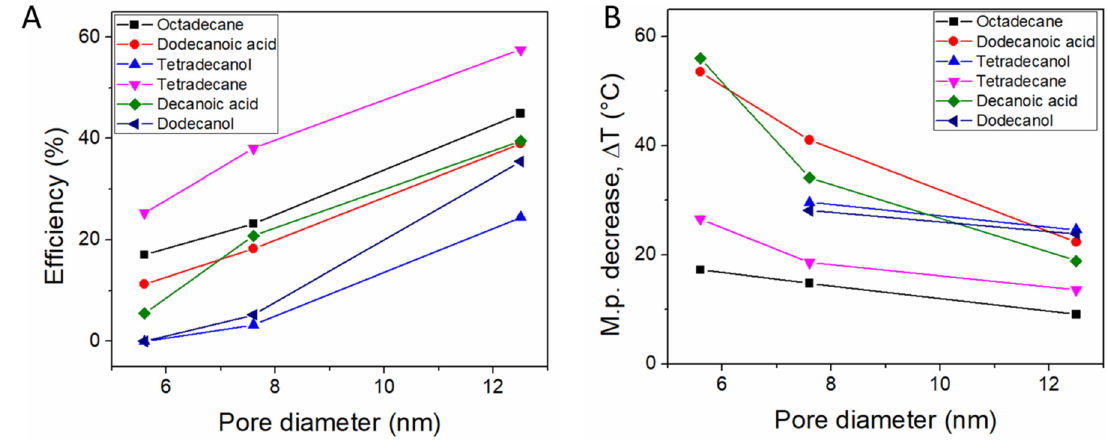
Figure 7. ( A ) Heat storage efficiency and ( B ) m.p. decrease versus SBA-15 mesopore diameter. Data from ref. [109].